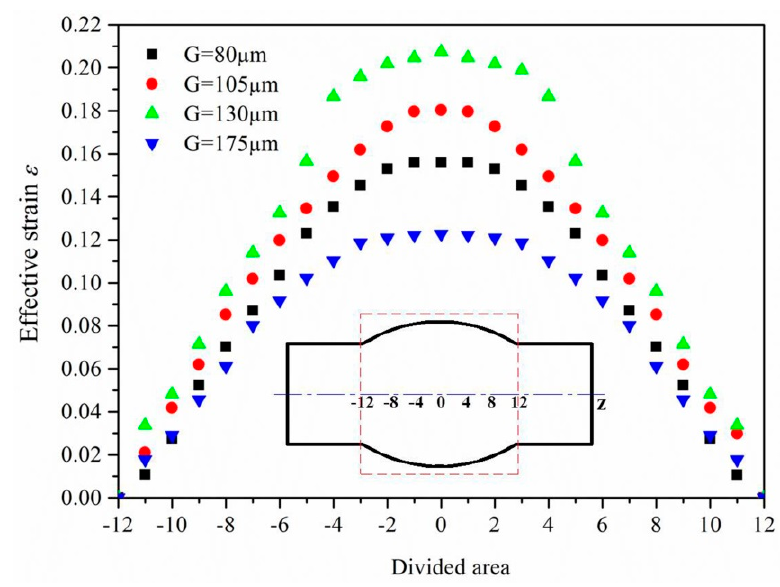
Figure 7. Effective strain distribution of bulged tubes with different grain sizes. Materials 2017 , 10 , 299